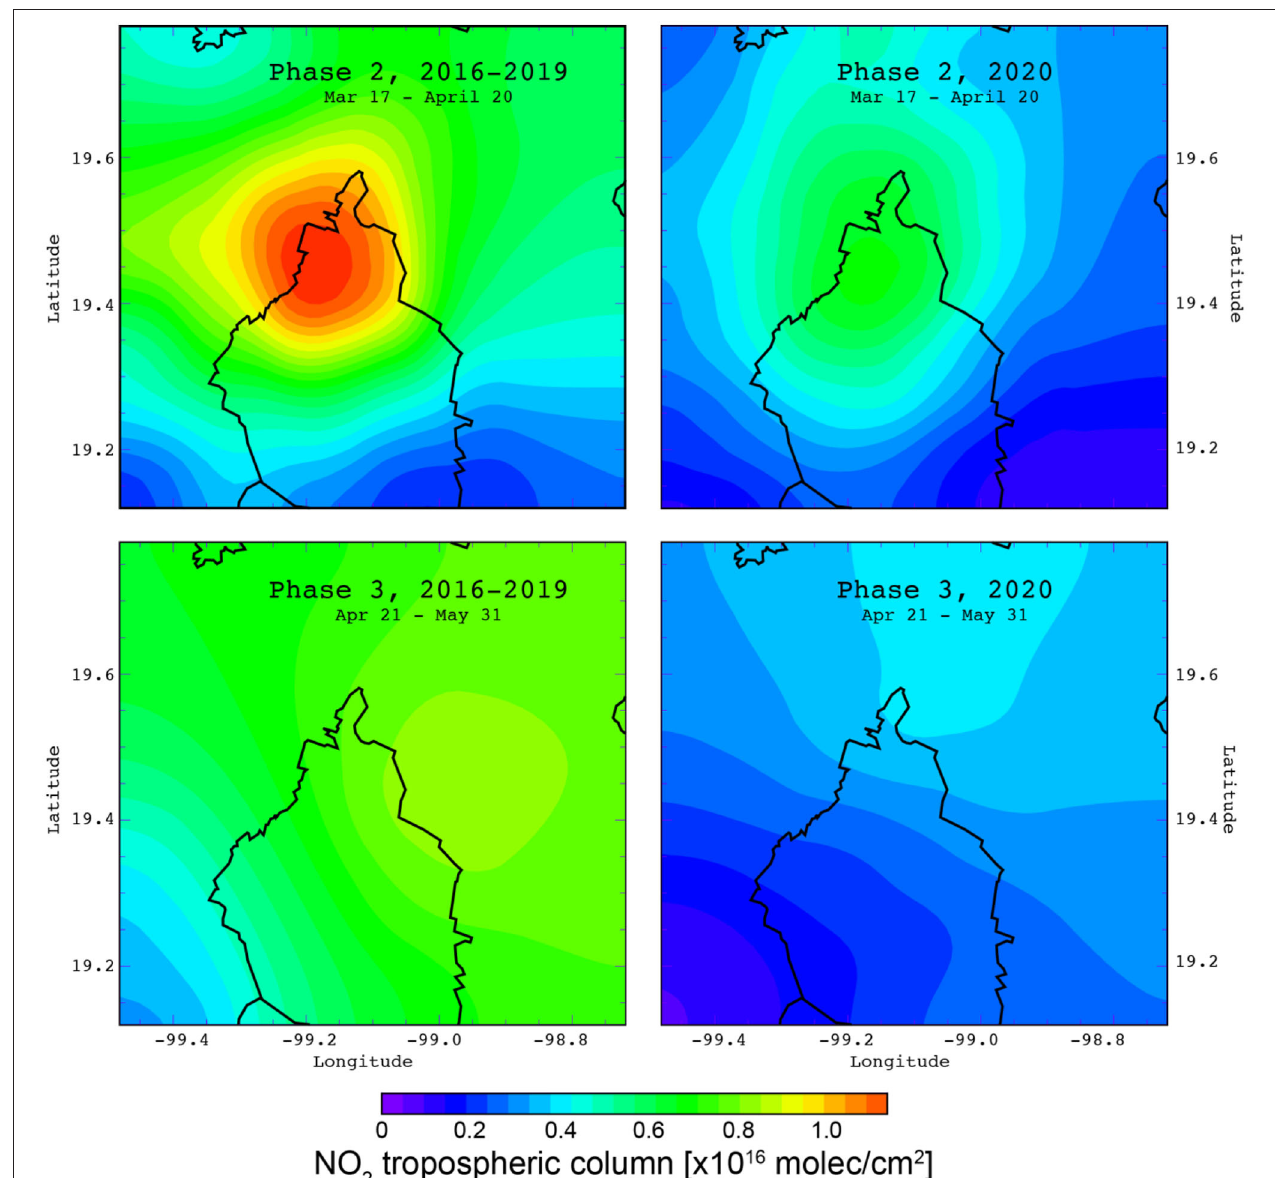
FIGURE 7 | NO 2 tropospheric column distribution maps constructed using satellite-based data from OMI over the MCMA during 2016–2019 (baseline) and lockdown Phases